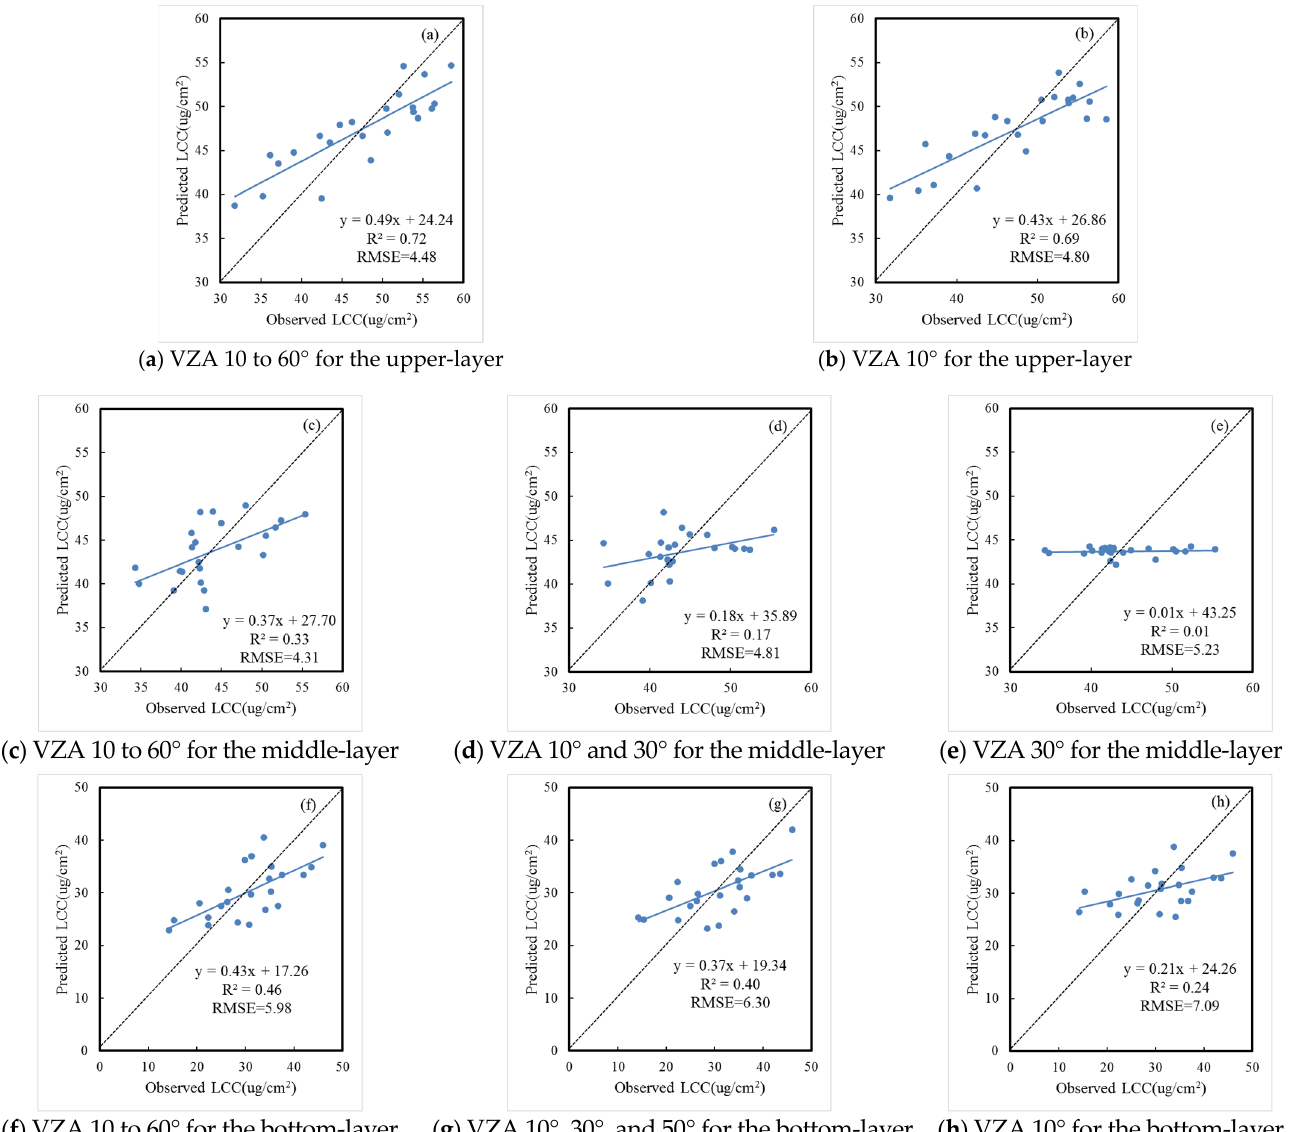
Figure 3. Comparison of the predicted and observed leaf chlorophyll content based on the TCARI using different VZA combinations for the upper-, middle-, and bottom-layers. ( a ) VZA 10 to 60 ◦ for the upper-layer. ( b ) VZA 10 ◦ for the upper-layer. ( c ) VZA 10 to 60 ◦ for the middle-layer. ( d ) VZA 10 ◦ and 30 ◦ for the middle-layer. ( e ) VZA 30 ◦ for the middle-layer. ( f ) VZA 10 to 60 ◦ for the bottom-layer. ( g ) VZA 10 ◦ , 30 ◦ , and 50 ◦ for the bottom-layer. ( h ) VZA 10 ◦ for the